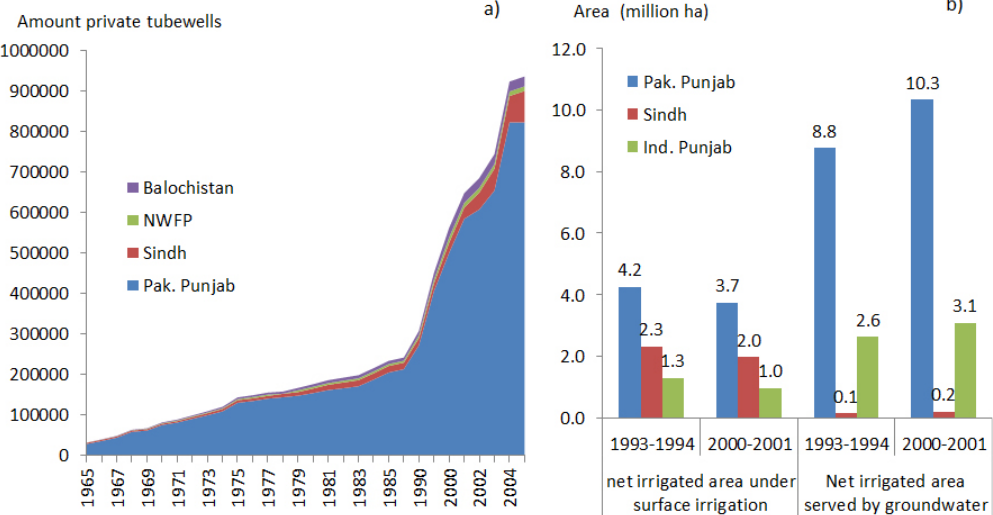
Fig. 7. (a) Increase in private tubewells in the main Pakistani provinces of the Indus Basin. Data source: GOP (2005); (b) net irrigated area under surface and groundwater irrigation for the periods 1993–1994 and 2000–2001 for the 3 provinces Sindh, Pakistani and Indian Punjab. Data Source: Shah et al. (2009) for Pak. Punjab and Sindh; Minor Irrigation Census 1993–1994 (Government of India, 2001; CWC, 2010) for Indian